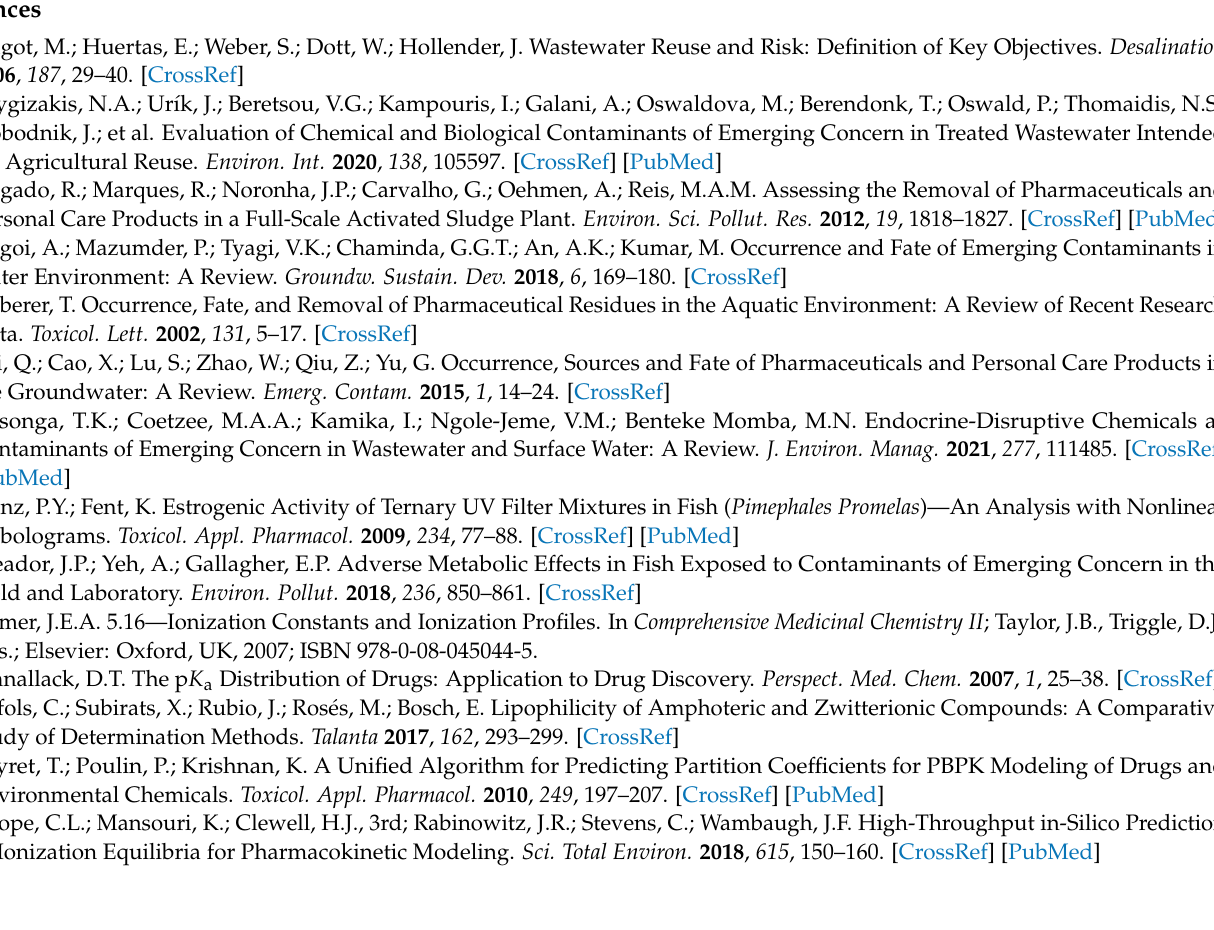
blue squares, zeolite: dark blue squares, compost: yellow circles, woodchips: green circles, and biochar: orange circles) and their ionization fraction (neutral: black line, anionic: red dash line, and cationic blue dot line) for the experimental pH range. Table S1: Composition of the SWW used in the